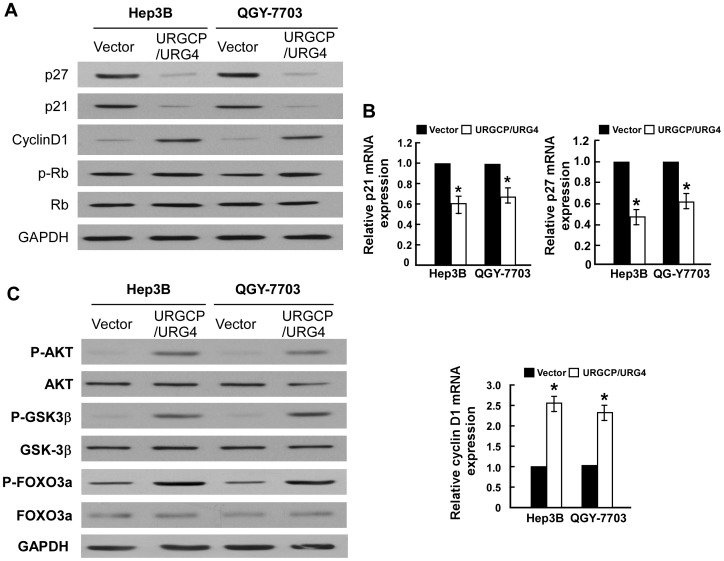
URGCP/URG4 induces proliferation through regulating CDK and CDK inhibitors.Western blotting analysis of expression of p21Cip1, p27Kip1, cyclin D1, phosphorylated Rb (p-Rb), and total Rb protein in indicated HCC cells (A). Real-time PCR analysis of expression of p21Cip1, p27Kip1, cyclin D1 in indicated cells (B). Western blotting analysis of phosphorylated Akt (p-Akt), total Akt, phosphorylated GSK-3β (p-GSK-3β), total GSK-3β, phosphorylated FOXO3a (p-FOXO3a-Ser253) and total FOXO3a proteins in indicated HCC cells (C). GAPDH was used as a loading control for all Western blots and mRNA expression levels were also normalized to GAPDH.